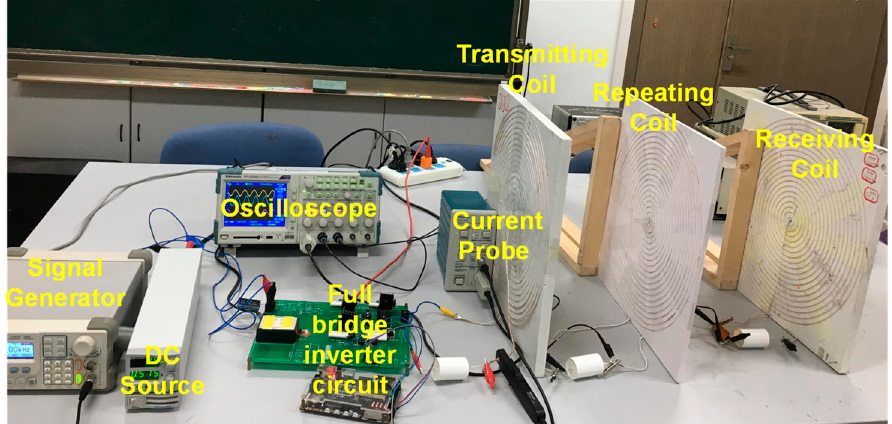
Figure 3. The layout of the experimental setup.